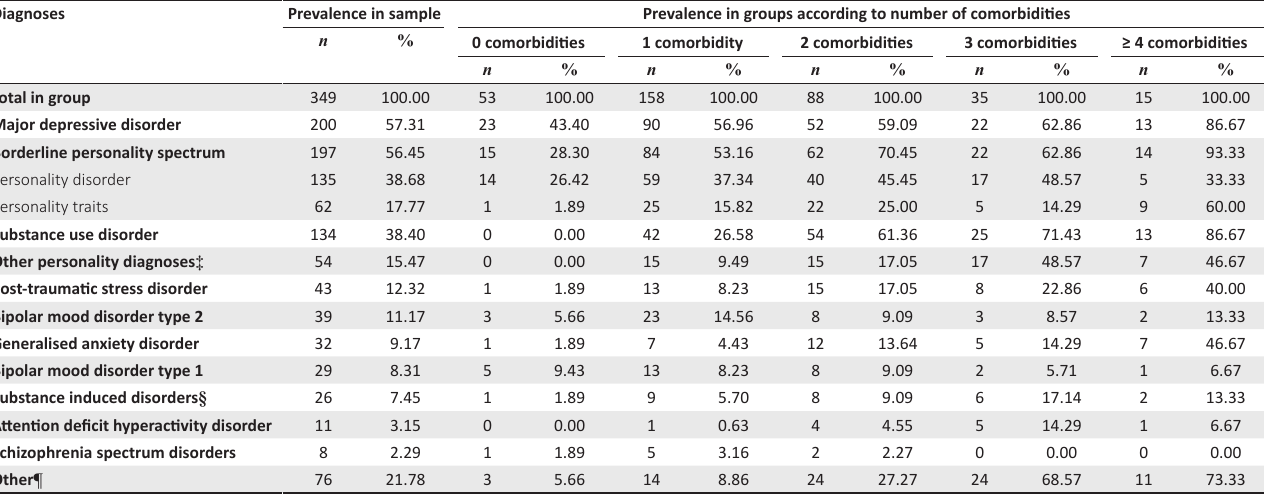
TABLE 2: Prevalence of psychiatric diagnoses in the entire sample compared with prevalence in subgroups based on the number of comorbidities. † Diagnoses Prevalence in sample